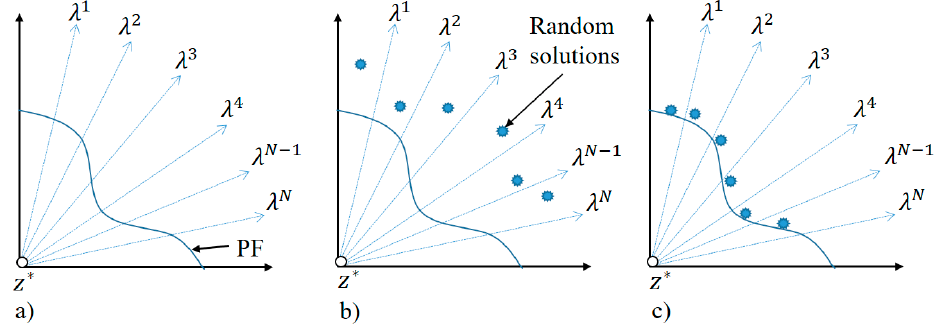
Figure 1. Decomposition strategy. ( a ) A MOP is divided into N sub-problems λ 1 ,. . ., λ N ; ( b ) N random solutions are generated; ( c ) over a finite number of generations, solutions are simultaneously improved.